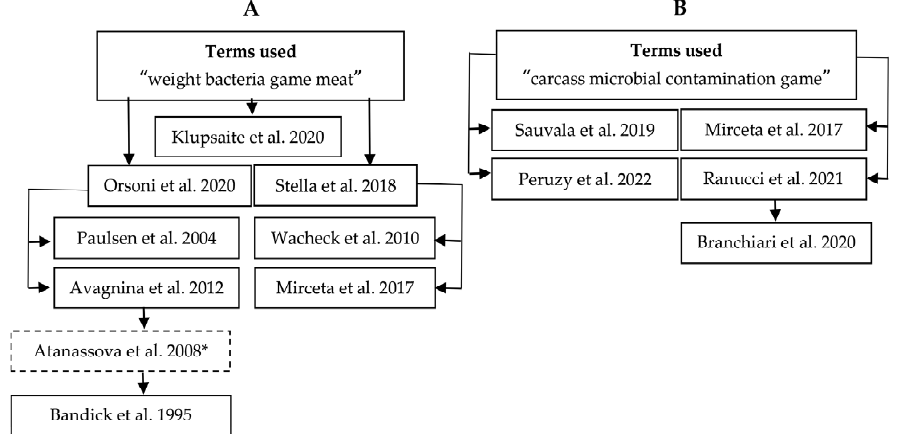
Figure 4. Original research articles found through the literature search in Google Scholar with the terms “weight bacteria game meat” ( A ) [3,7,9,14–16,18,27,28] and “carcass microbial contamination game” ( B ) [5,6,8,9,13]. Arrows represent direct hits of the search term or the primary reference that cited the related study. * The discontinuous frame indicates a reference that was excluded by the described criteria, but served as a lead for another Table 3. Environmental factors that may influence the initial microbial load of game carcasses including animal species, sample size, p -value and bacterial group examined, reported in the original research articles.